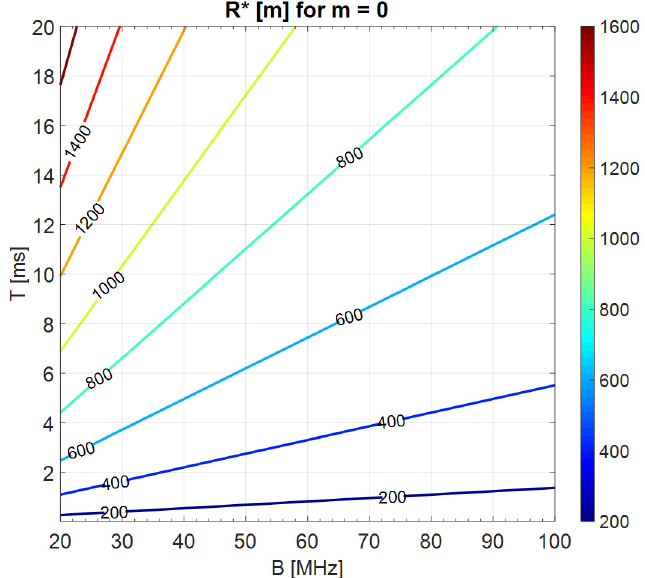
Figure 12. Level curves (in meters) of the transition Range R* varying B and T in the ideal case of flat spectrum (m = 0).